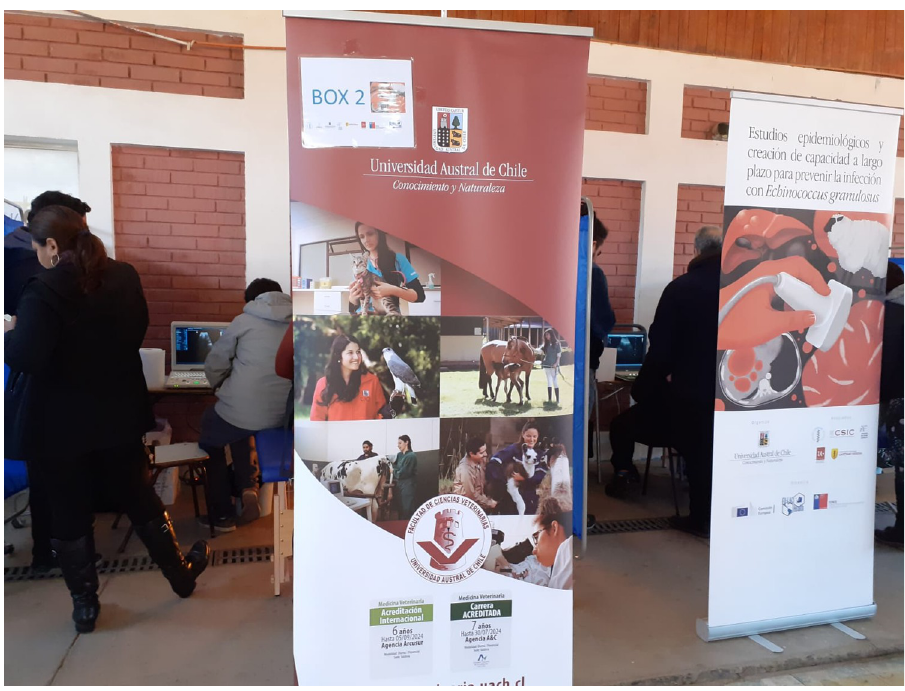
Fig 2. Example of a US-hub where abdominal US screening sessions were carried out in the study area.